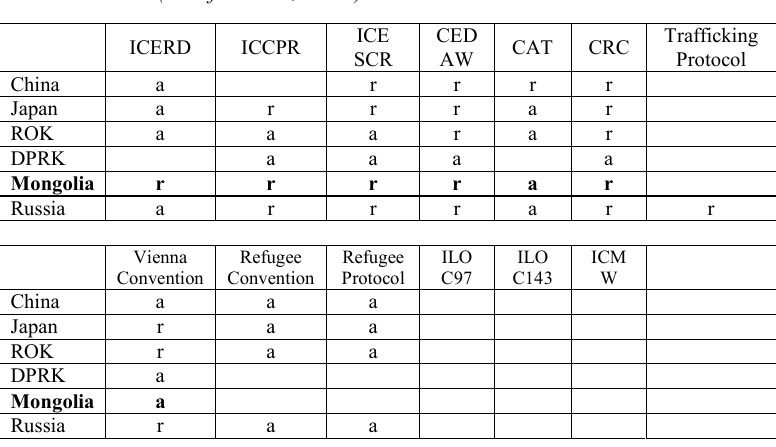
Table 2 : International Human Rights Treaties and States Parties in Northeast Asia (As of June 3, 2005)